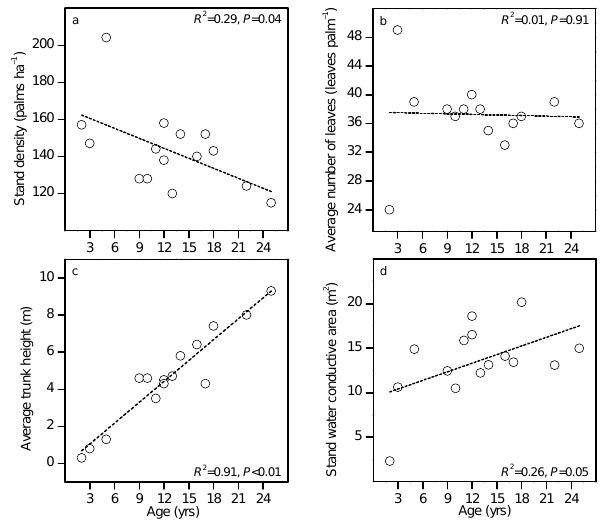
Figure 2. The change of stand density (a) , average number of leaves per palm (b) , average trunk height (c) , and stand water conductive area (d) over age in the 15 studied oil palm